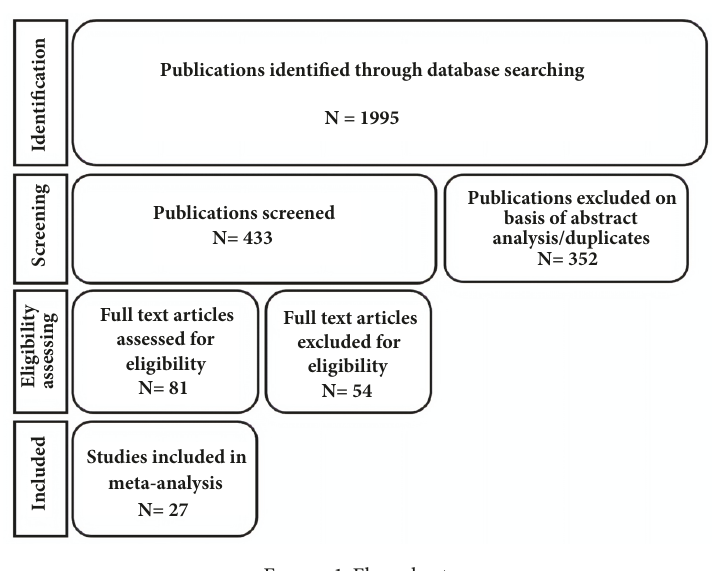
Figure 1: Flow chart.